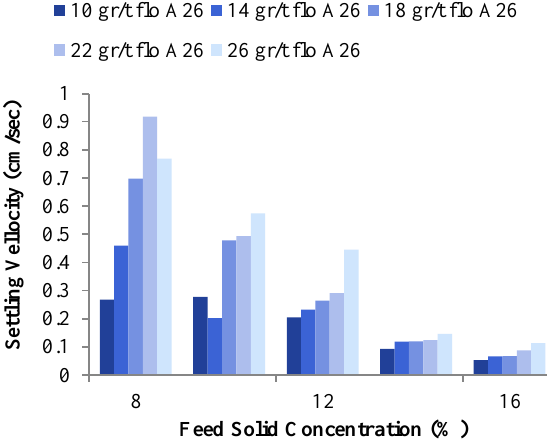
Figure 5. Variation in percentage of solids deposition rate of feed at different levels of flocculant